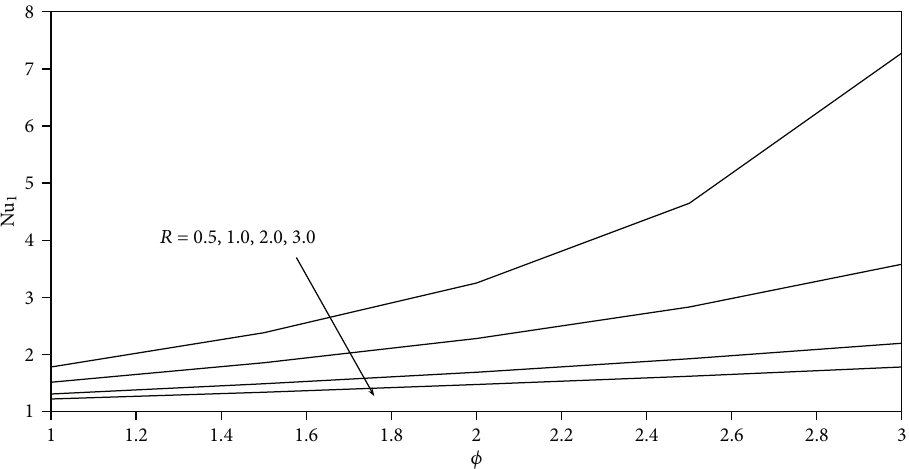
ϕ for di ff erent values of R 1 Þ versus